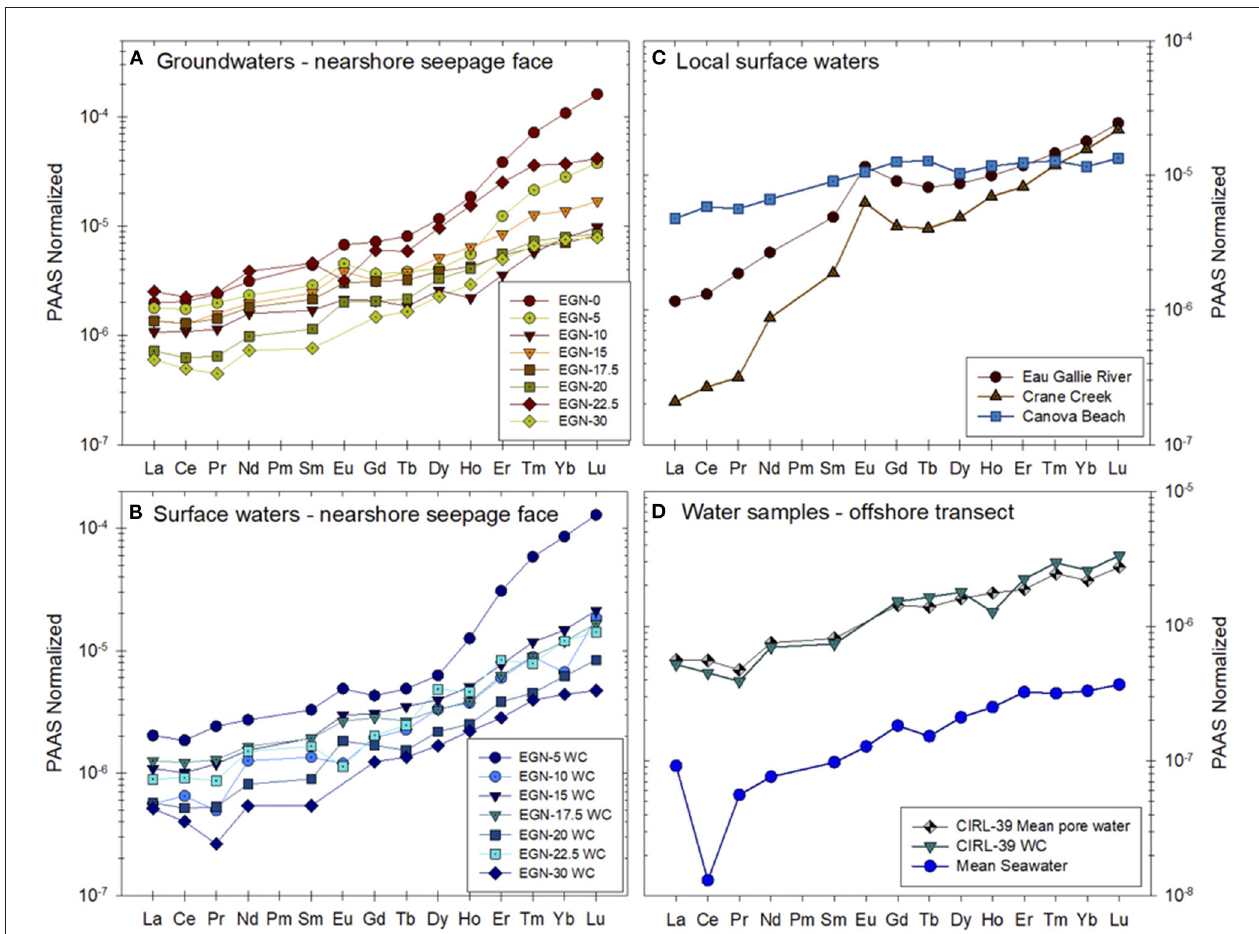
FIGURE 4 | PAAS-normalized REE concentrations of (A) groundwaters from the nearshore transect, (B) surface waters collected along the nearshore transect, (C) local surface waters from Eau Gallie River, Crane Creek, and Canova Beach, and (D) pore water from multisampler CIRL-39 and the overlying water column at the same location [data from Chevis et al. (2015b)]. The nearshore transect groundwaters shown in (A) and the CIRL-39 pore water are the mean values of the REEs measured at each sampling port from each multisampler (see Supplementary Table 5 ). Mean seawater is an average open ocean seawater computed using data from Piepgras and Jacobsen (1992), Westerlund and Öhman (1992), Sholkovitz et al. (1994), German et al. (1995), Nozaki and Zhang (1995), Zhang and Nozaki (1996) , and Nozaki and Alibo (2003), and is included for comparison. PAAS is the Post-Archean Australian Shale composite that is given in McLennan